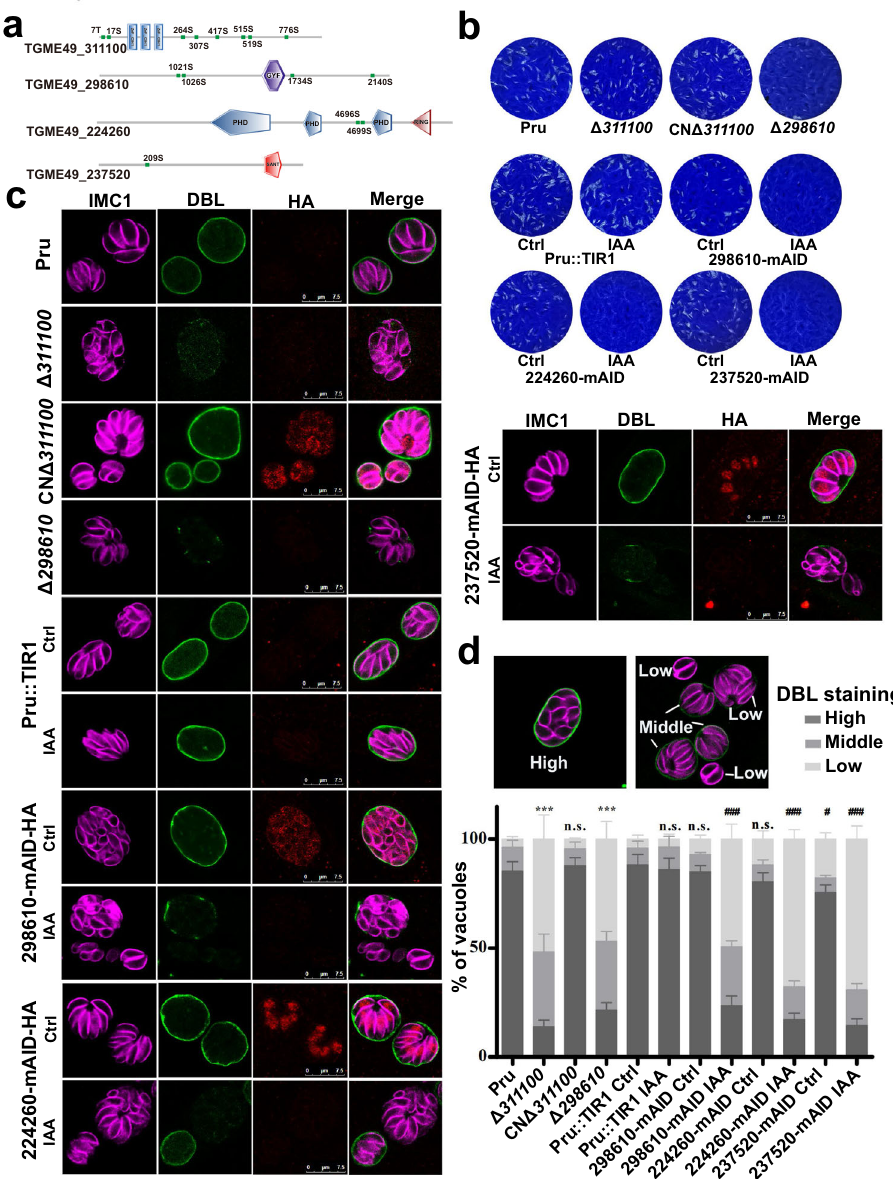
Fig.8|FourhyperphosphorylatedproteinsinPru Δ pp2a-c strainareimportant for parasite differentiation. a Schematic representation of the domain archi- tecture of four hyperphosphorylated proteins in Pru Δ pp2a-c strain. b Representative images showing the results of the plaque assay of the indicated strains grown under normal culture conditions for 7 days. Images are representa- tiveofthreeindependentexperiments. c Representativevacuolesofdifferentiation after 72h exposure to alkaline medium. FITC-labeled Dolichos bi fl orus lectin (DBL) speci fi cally stains the differentiated vacuoles and the parasites were stained with IMC1andmAID-HAtaggedproteinsweredetectedwithanti-HAantibody.Scalebar,